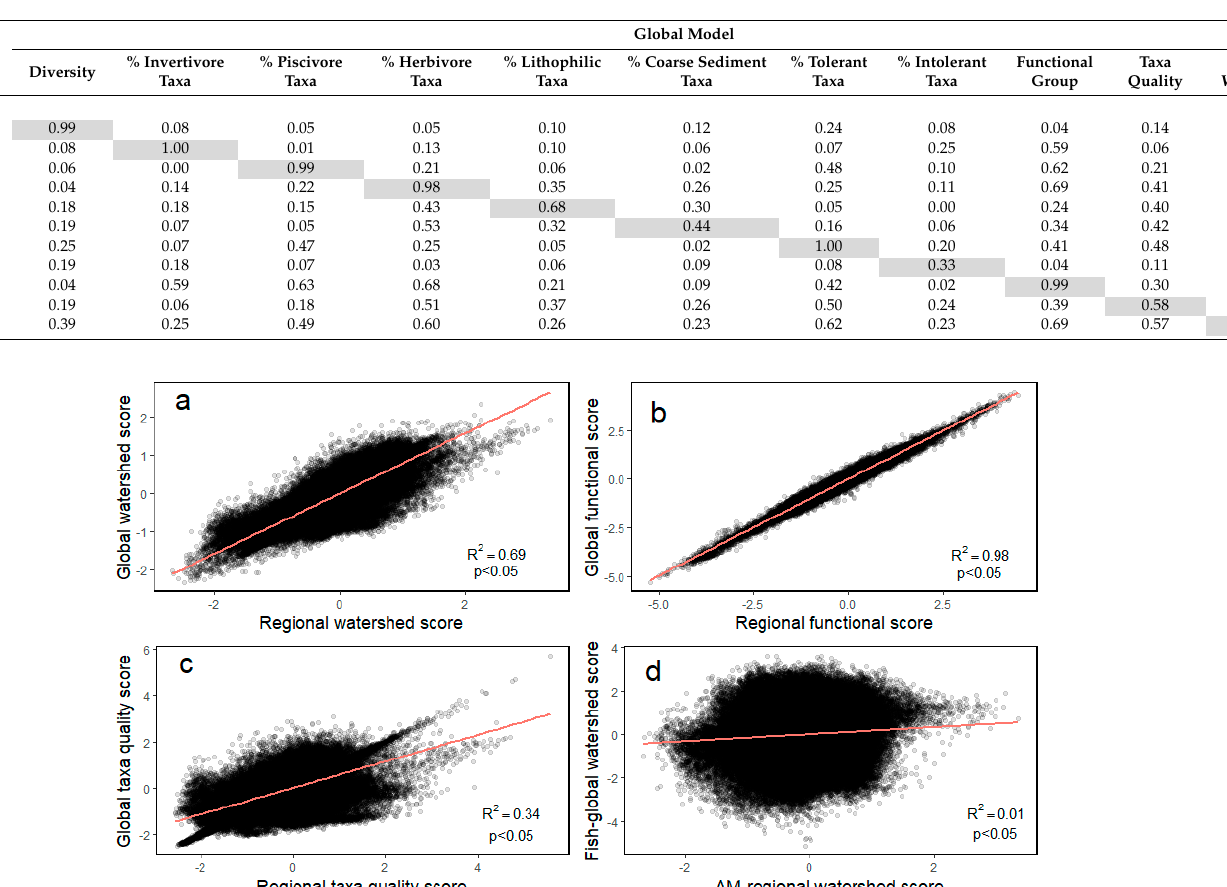
Table 8. Pearson correlation coe ffi cients for the global and regional models for all response variables. Correlations for the same response variables for each model are highlighted in gray.